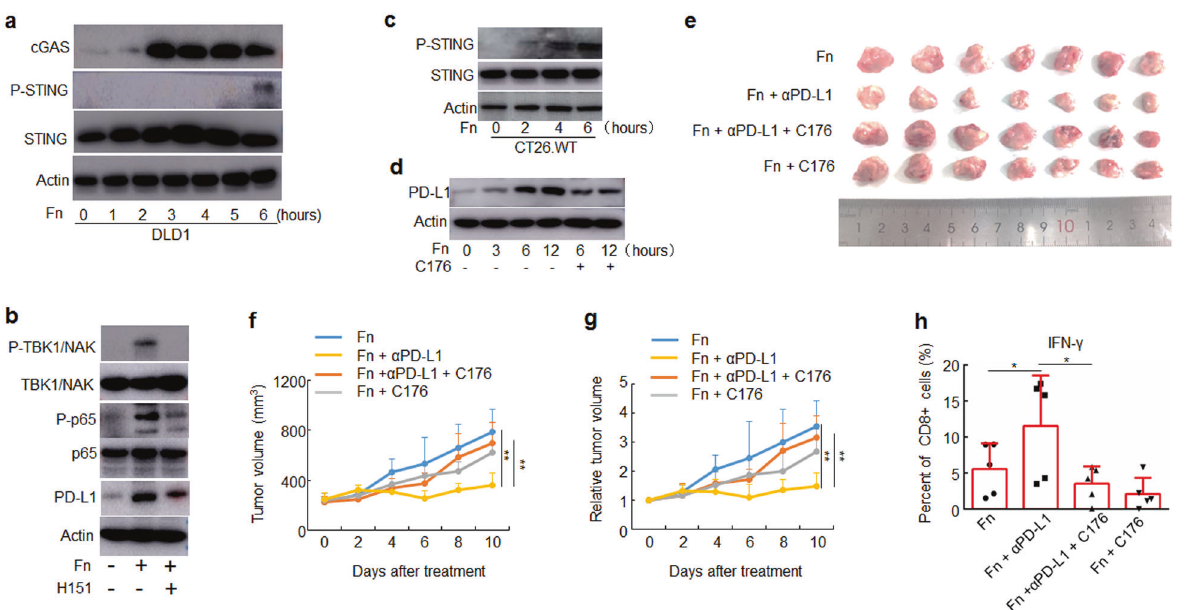
Fig. 5 F. nucleatum enhanced the therapeutic effect of PD-L1 blockade by activating STING signaling. a – d The indicated proteins were detected by Western blotting. Actin was used as a loading control. a DLD1 cells were treated with Fn (1:1000) for different time course. b DLD1 cells were pre-treated with H151 for 2 h, and then treated with Fn (1:1000) for 12 h. c CT26.WT cells were treated with Fn (1:1000) for different time course. d CT26.WT cells were pre-treated with C176 for 2 h, and then treated with Fn (1:1000) for different time course. e – h CT26.WT cells were subcutaneously injected into BALB/c mice ( n = 7 for each group). Tumor-bearing mice were pre-treated with C176 or vehicle, then intratumorally injected with F. nucleatum or PBS and intraperitoneally injected treated with an anti-PD-L1 mAb or an isotype control mAb every three days until the end of the experiment. Tumor volumes were measured. e An image of tumors collected at the end of the experiment is shown. f , g Tumor volumes and relative tumor volumes at various time points are shown. One-way ANOVA and Bonferroni ’ s multiple comparison test. h Flow cytometry was used to detect the proportion of IFN- γ + cells in CD8 + TILs from mice. One-way ANOVA and Bonferroni ’ s multiple comparison test. * P < 0.05; ** P < 0.01. Fn, F.